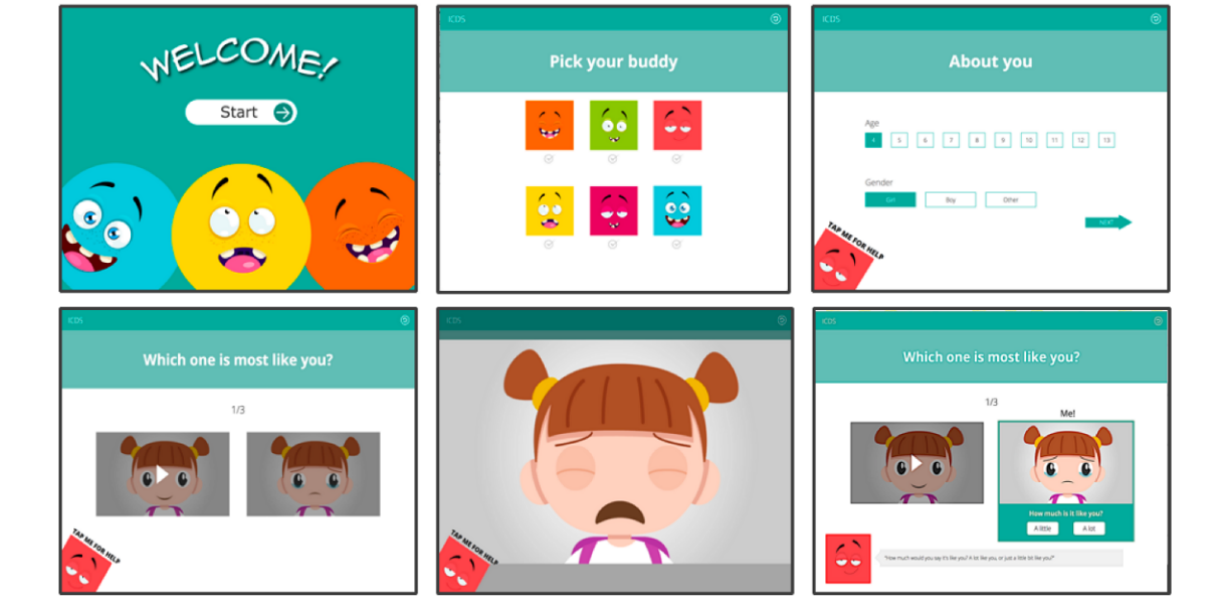
Figure 2. Screenshots from early prototype of the Interactive Child Distress Screener (ICDS) interface. From left to right: Top row: welcome screen, avatar (“buddy”) selection, and demographics. Bottom row: animation pairs, video pop-out, “How much is it like you?” selection with audiovisual instruction text spoken by the “buddy” helper.